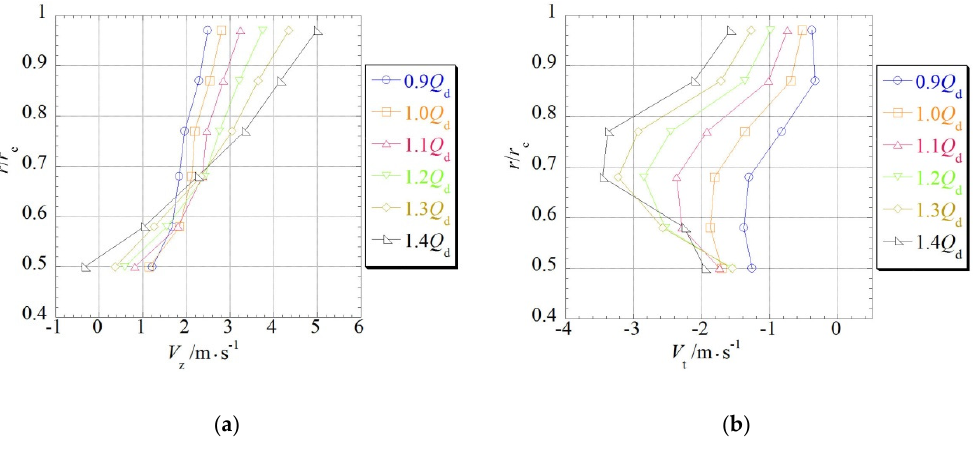
Figure 7. The rear rotor axial velocity and circumferential velocity of original model. ( a ) Axial velocity. ( b ) Circumferential velocity.